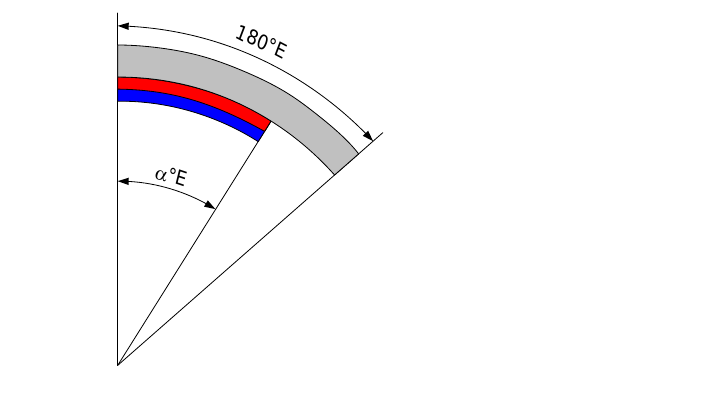
Figure 7. Determination of the magnet length in relation to its angular measure in electrical degrees.